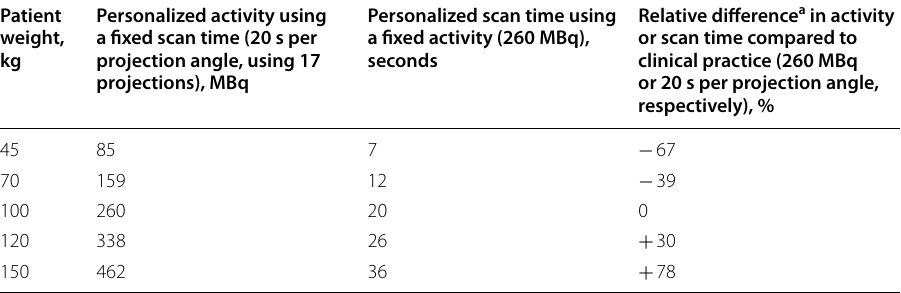
a Negative relative differences indicate a reduction in activity or scan time, whereas positive relative differences indicate increased activity or scan time